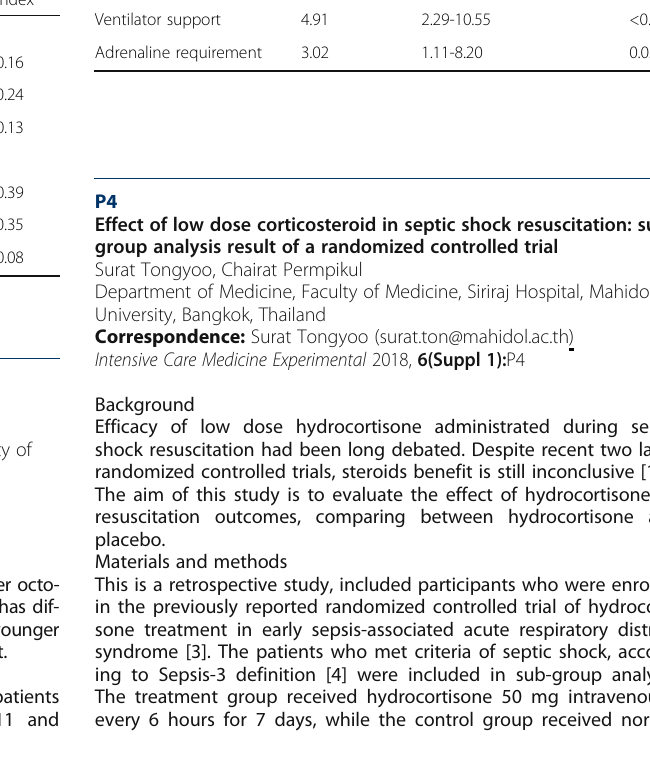
Table 1 (abstract P3). Multivariate analysis for predictive factor associated with 30-day mortality Parameter Relative risk 95% confidence Table 1 (abstract P2). ROC curve analysis identify cut-off point of lactate to predict hospital outcome Parameter Cut-off point